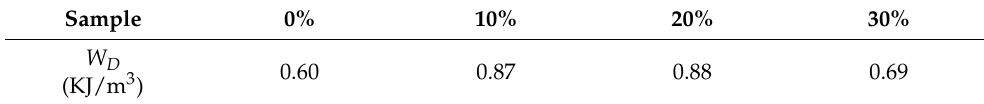
Table 2. Volumetric work density values of PEO/Nafion-IPMCs with varying PEO contents.